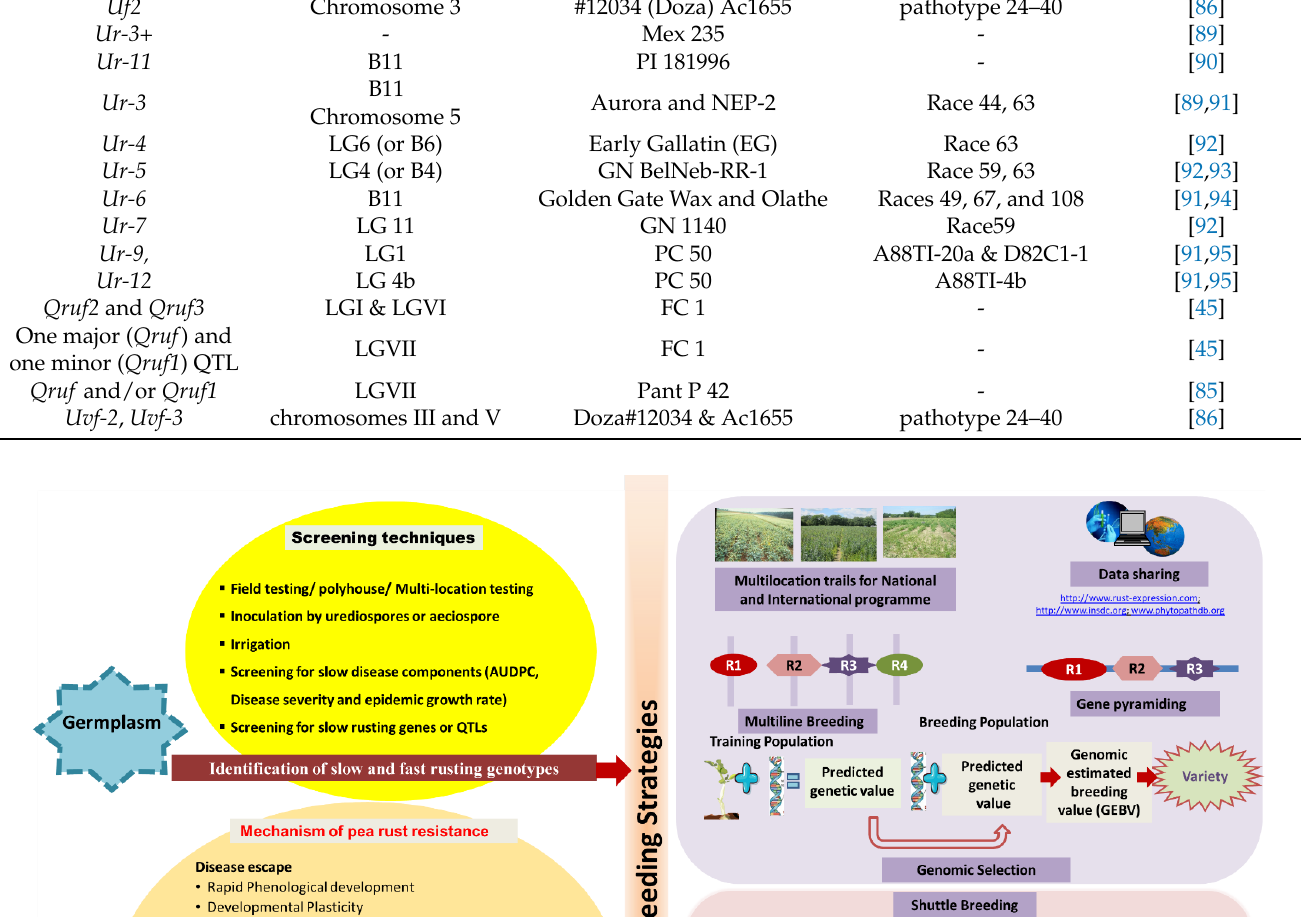
Table 3. List of resistant genes/QTLs against Uromyces viciae-fabae Pers. de-Bary.